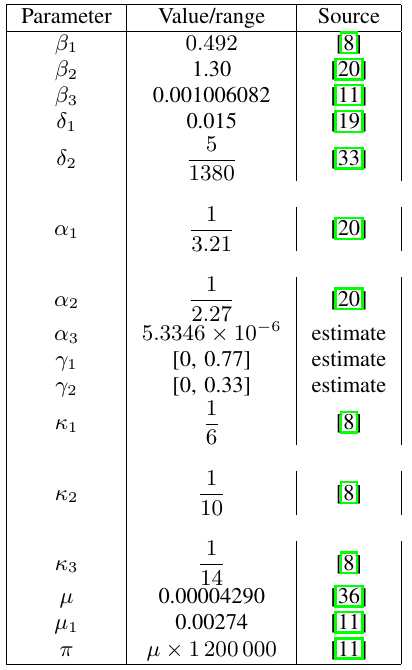
TABLE III: Numerical values for the parameters of the South African case